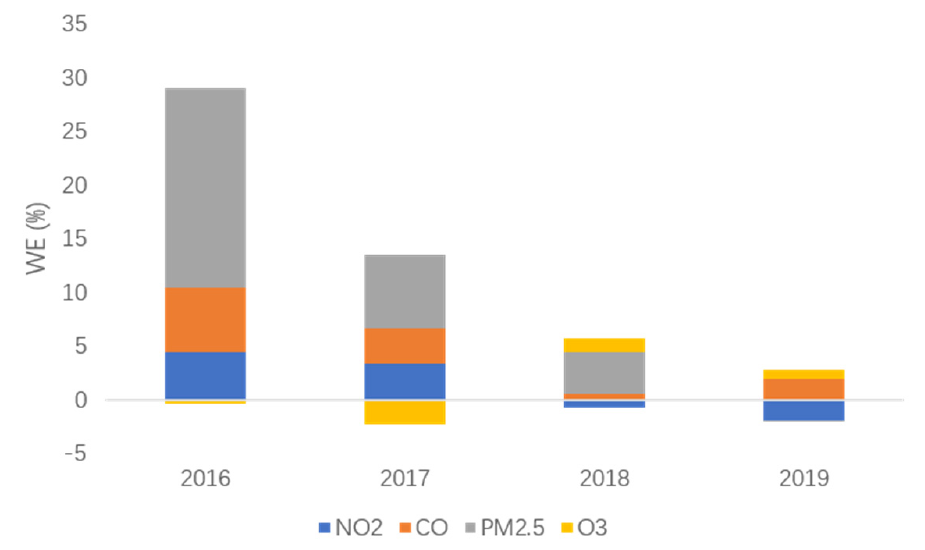
Figure 14. Cumulative diagram of inter-annual variation deviation of weekend effect.